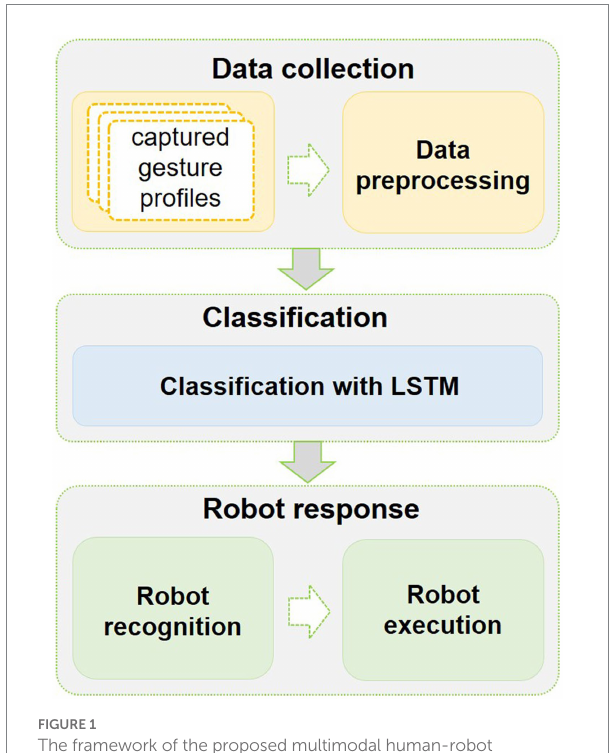
FIGURE 1 The framework of the proposed multimodal human-robot interaction (HRI)